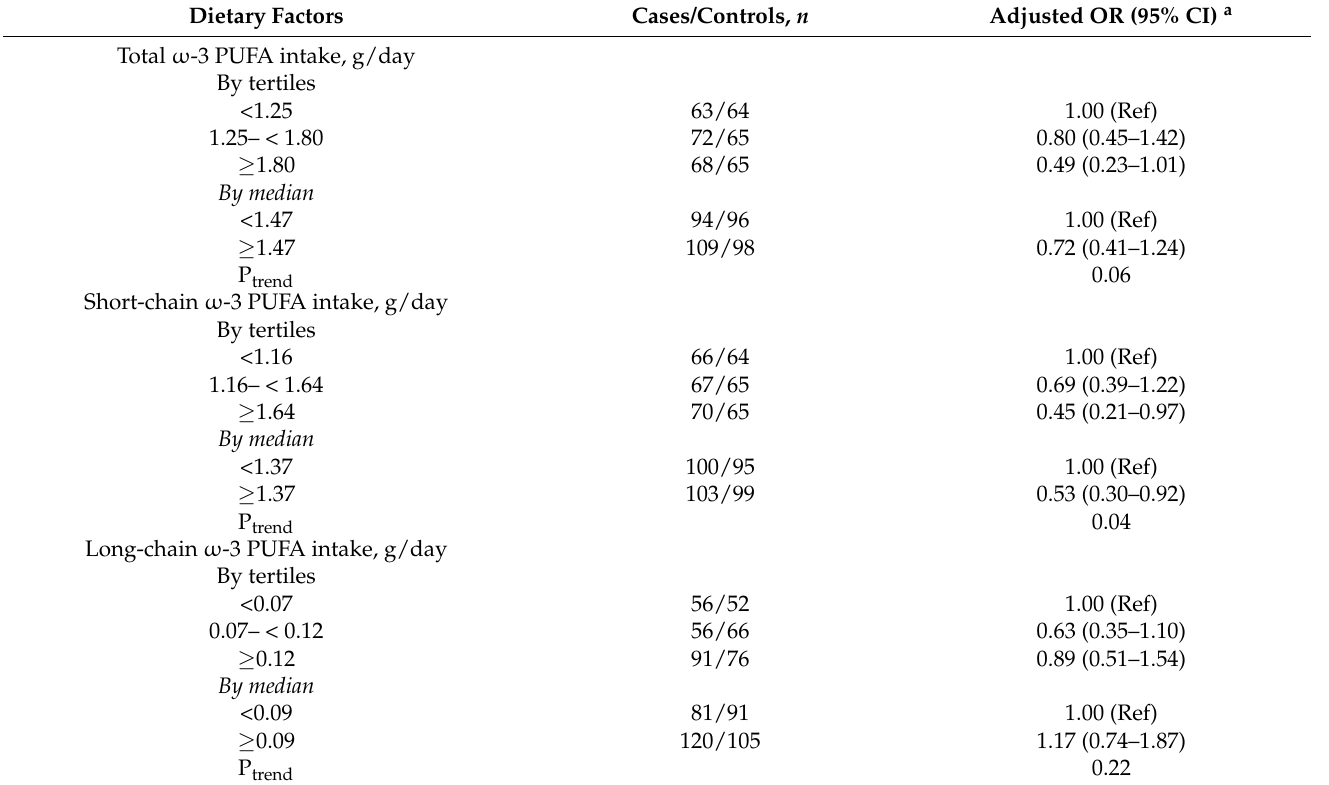
Table 2. Association between ω -3 polyunsaturated fatty acid intake and colorectal adenomas, Diet and Health Study V, 2008–2010 ( n =